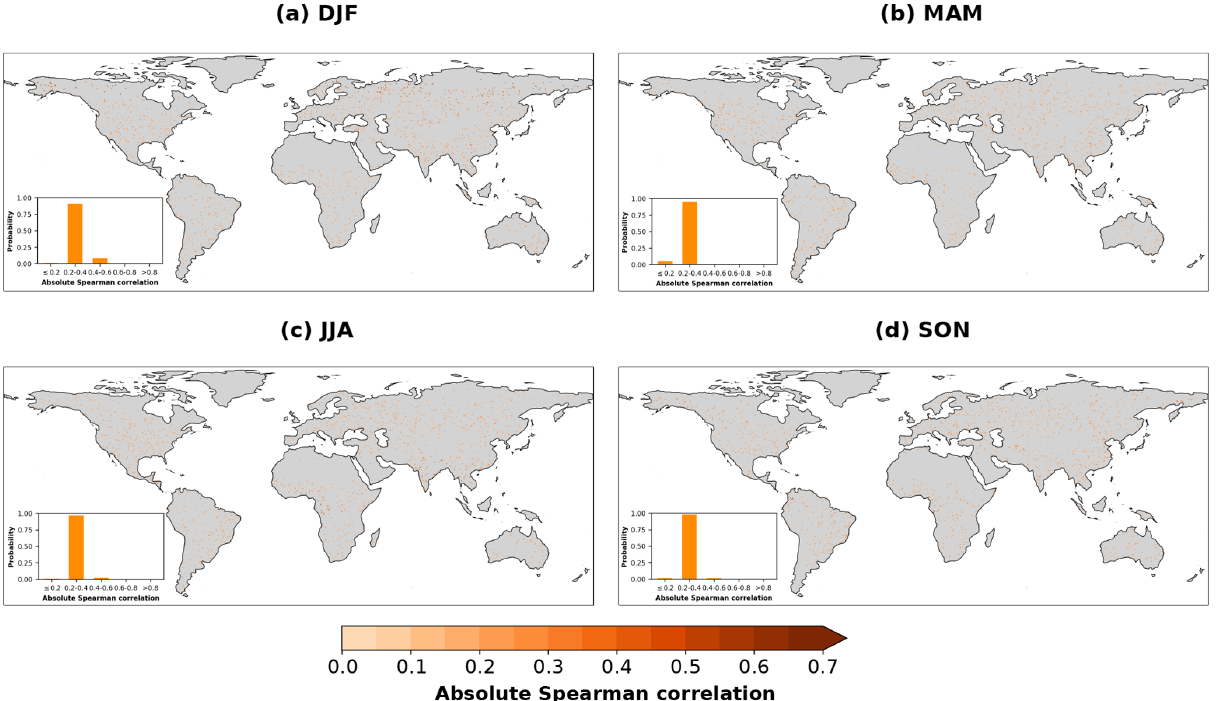
Figure A5. Strongest absolute Spearman correlation coefficient between the Earth system variables in Table 1 randomly permuted and the temperature forecast error in Fig. 2. The inset bar plots represent the histograms of these global Spearman correlation values.